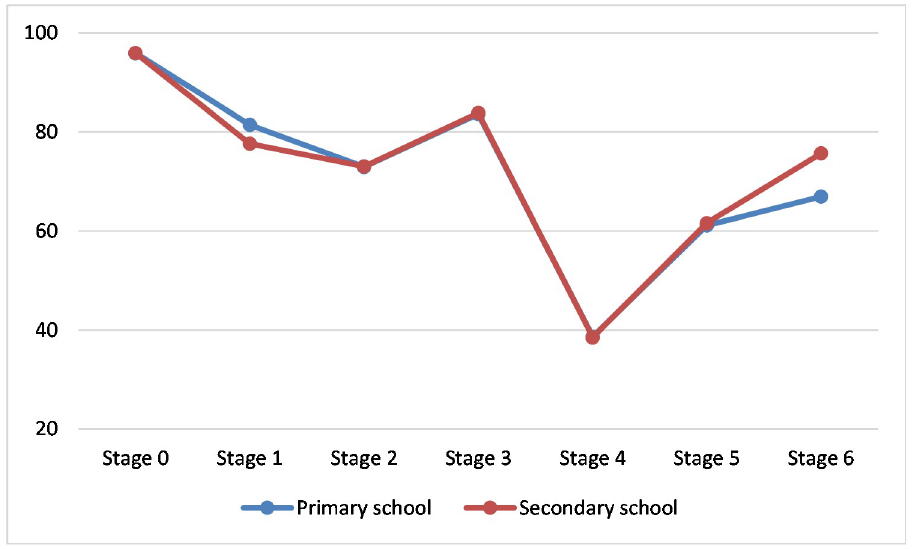
Fig 4. SoC intensity according to level of class